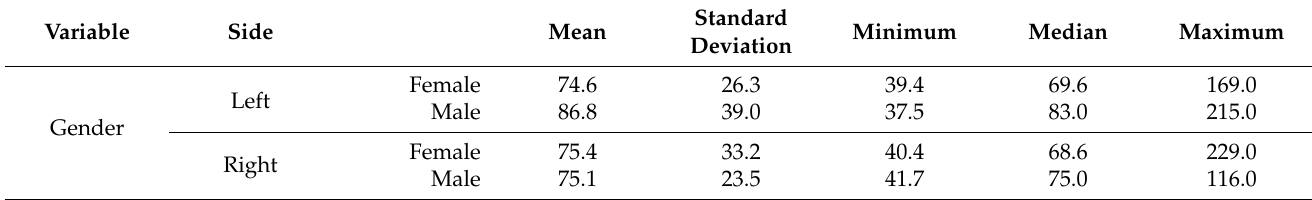
Table 5. Position and dispersion measurements of the frontal septal cell by